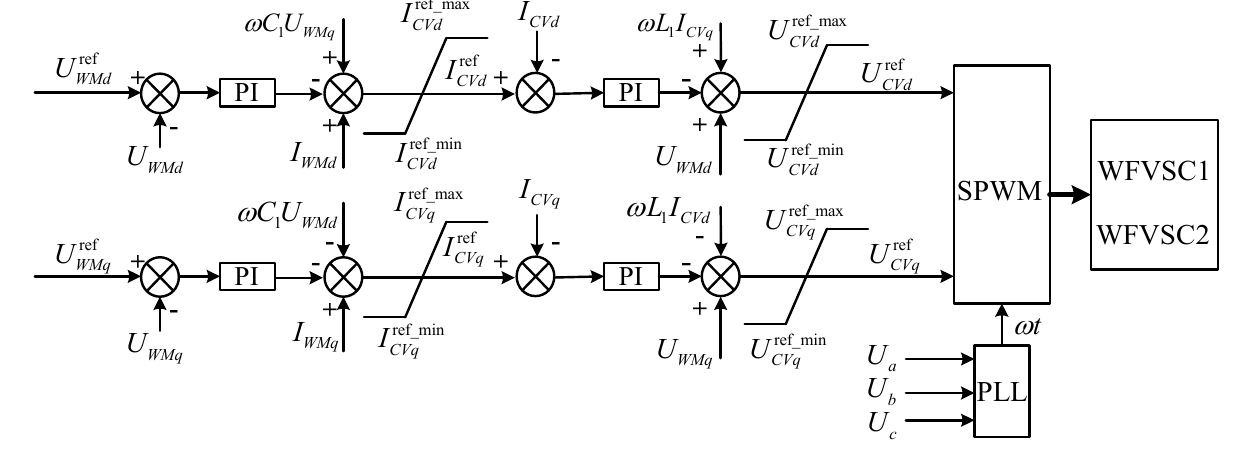
Figure 5. Control block diagram of VSC offshore wind farm.